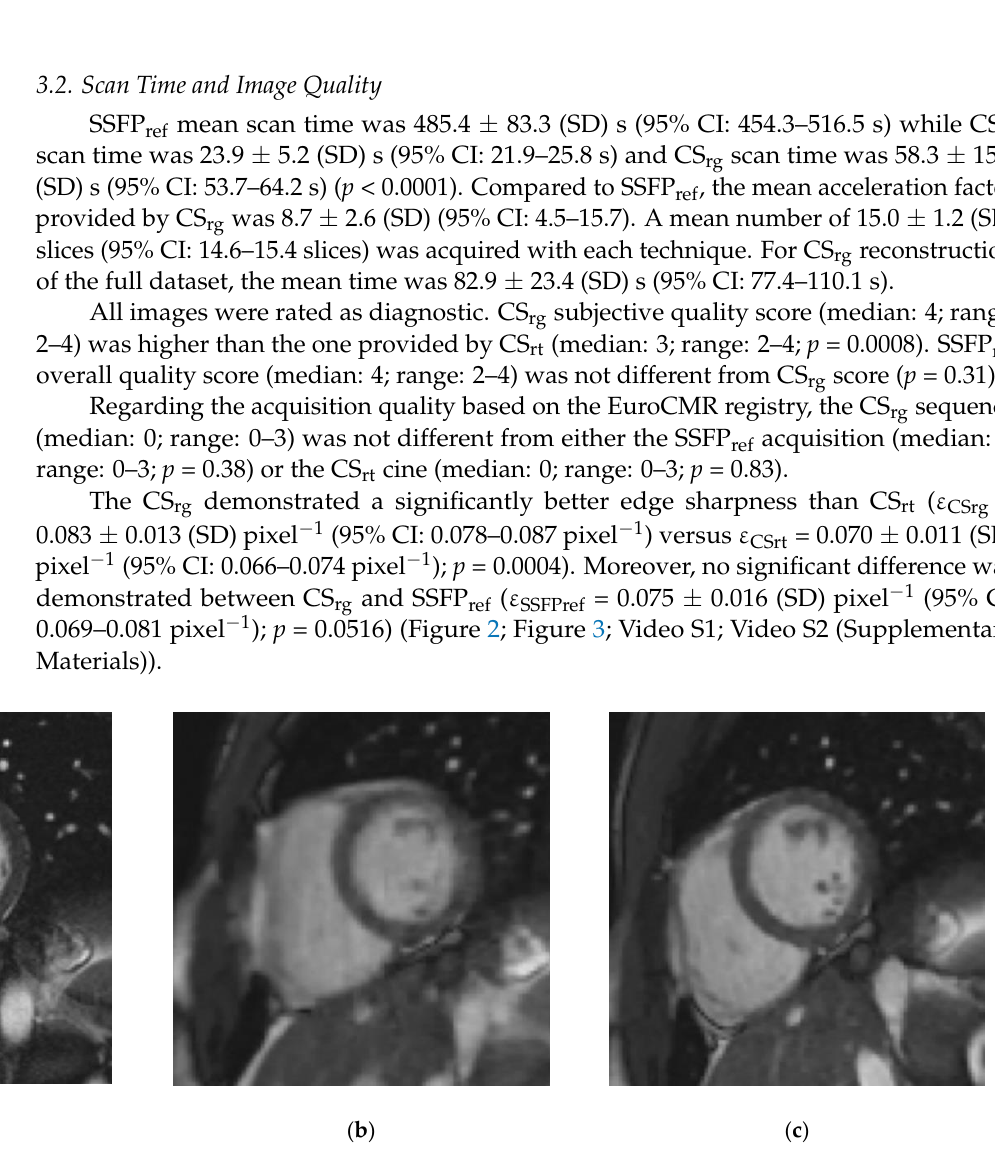
Figure 2. Midventricular short-axis cine slice acquired with the three cine sequences in a 37-year-old patient referred for myocarditis suspicion. ( a ) Reference steady-state free precession cine: Likert scale = 4/4; EuroCMR score = 0/10; ε = 0.082 pixel − 1 ; LVEF = 59%, LVEDV = 135 mL, LVM = 83 g, RVEF = 63%, RVEDV = 159 mL; ( b ) Real-time compressed sensing cine: Likert scale = 4/3; EuroCMR score = 0/10; ε = 0.056 pixel − 1 ; LVEF = 60%, LVEDV = 133 mL, LVM = 81 g, RVEF = 61%, RVEDV = 153 mL; ( c ) Retrogated compressed sensing cine: Likert scale = 4/4; EuroCMR score = 0/10; ε = 0.081 pixel − 1 ; LVEF = 58%, LVEDV = 133 mL, LVM = 86 g, RVEF = 62%, RVEDV = 164 mL. Abbreviations: ε , edge sharpness; LVEF, left ventricular ejection fraction; LVEDV, left ventricular end-diastolic volume; LVM, left ventricular myocardial mass; RVEF, right ventricular ejection fraction; RVEDV, right ventricular end-diastolic volume.